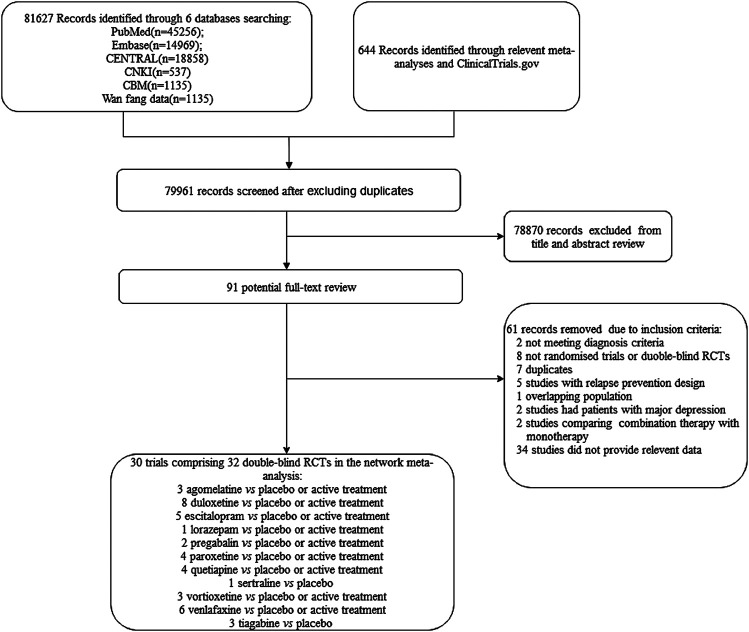
Flow diagram of study selection.